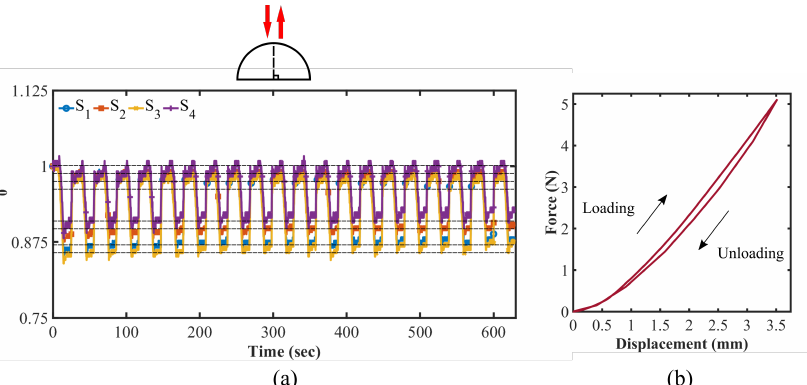
Figure 14. Cyclic loading test results; ( a ) sensor readouts for cyclic loading, ( b ) corresponding force- displacement hysteresis loop for one loading-unloading cycle; side view of the sensor is presented, red arrows representing the exerted and retracted cyclic force directions along vertical axis; dashed lines are used for referencing the individual flex sensor